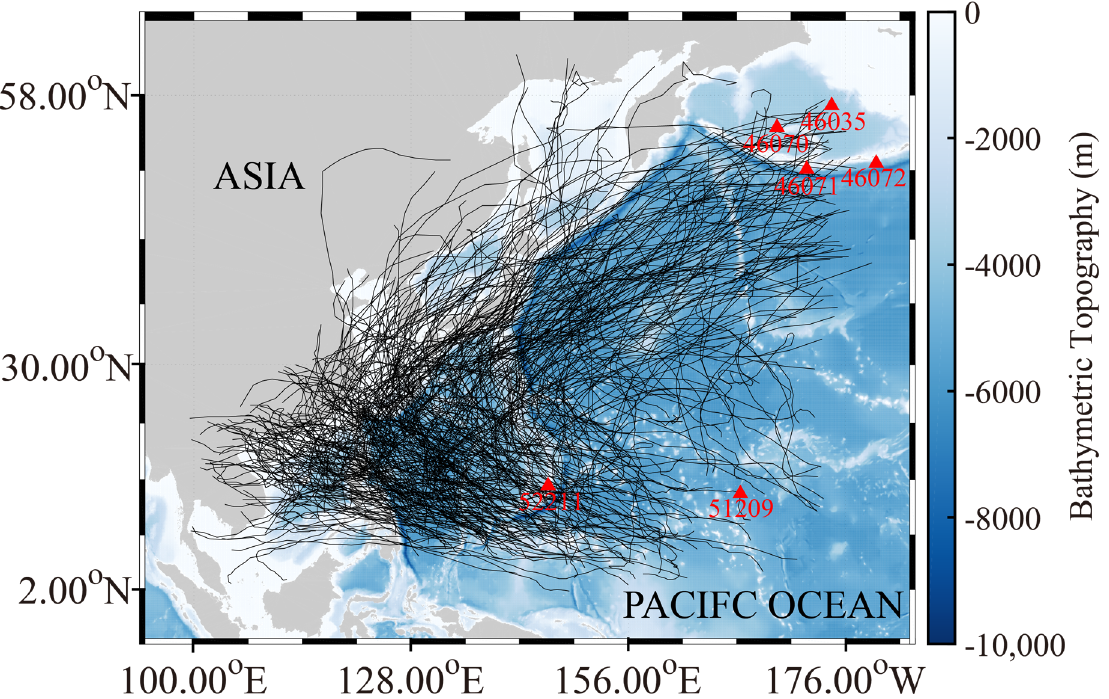
Figure 1. Bathymetric topography of the North West Pacific Ocean with high spatial resolution at a 0.1 ° grid in the area between 5 ° S and 65 ° N, 93 ° and 193 ° E. The color indicates the bathymetric topography. The red triangle indicates the locations of the National Data Buoy Center (NDBC) buoys. The black lines represent the typhoon track from Japan Meteorological Agency (JMA).